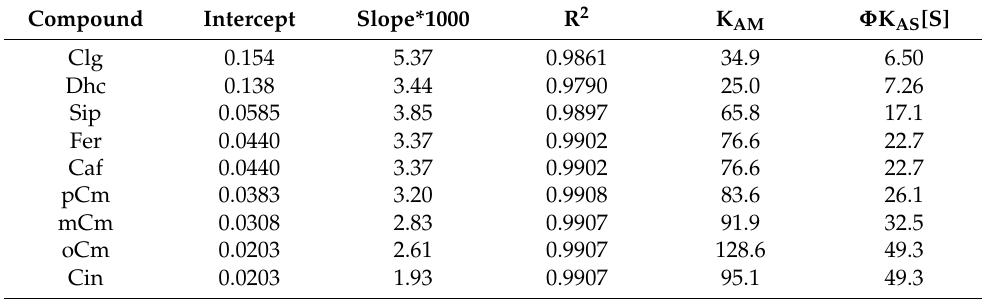
Figure 6. The relationship between the retention factor (k) and the surfactant concentration using Tween 20 ( A ) and Tween 40 ( B ). Tween 20 ( A ) and Tween 40 ( B ). Table 4. Linear regression equations for 1/k vs. [Tween 20, mM] plots (Figure S3 data) for HCAs. and their equilibrium constants (Equation (1) in above